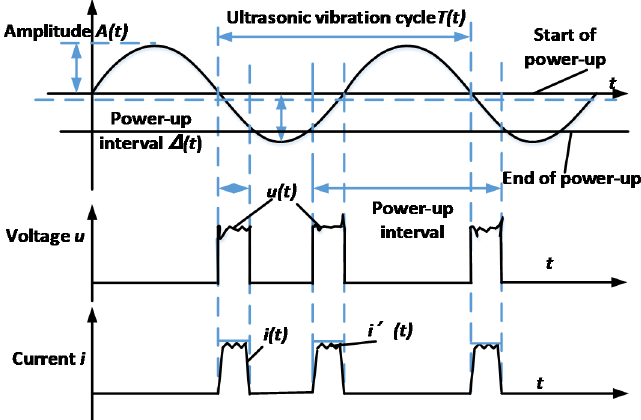
Figure 2. Schematic diagram of the multi-energy effect of UCEM. Where u ( t ) represents the interpolar voltage, i ( t ) represents the interpolar electrolytic current waveform (corresponding to the low frequency signal of the current waveform), and i (cid:48) ( t ) is the microspark discharge current waveform (corresponding to the high frequency signal of the current waveform), A ( t ) and T ( t ) represent the ultrasonic amplitude and ultrasonic vibration period parameters respectively, and the ∆ ( t ) is related to the UCEM gap parameters. All these parameters affect the machining accuracy, efficiency, and